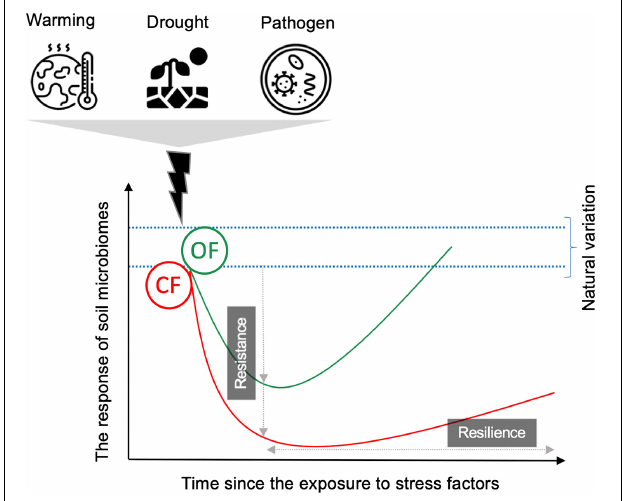
FIGURE 2 | Conceptual figure showing soil microbial stability, in terms of resistance and resilience, in organic (OF) and conventional (CF) farming systems in response to stressors (e.g., warming, drought, pathogen). Resistance refers to the extent to which microbial communities withstand changes after exposure to stress factors (immediate or sudden responses). Resilience is the capacity of the microbiome to recover from the stress factor (the response over time). The response of the soil microbiome can be considered as changes in microbial function (process rates or functional genes) and/or community structure (species present in the community and their abundance). For details about possible scenarios on microbial stability, see the